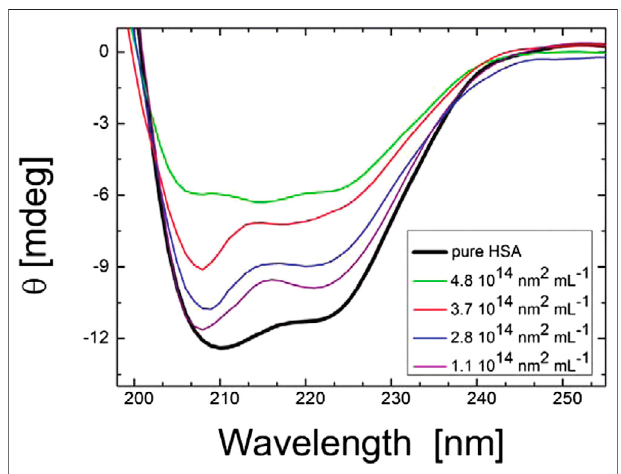
FIGURE 3 | CD spectra of HAS with citrate-stabilized silver nanoparticles (diameter of 36 nm with NP surface site concentrations ranging from 1.1 × 1014 to 4.8 × 1014 nm 2 mL − 1 and a protein concentration of 0.052 mg mL − 1 ). The fi gure and caption have been adapted with permission from (Gebauer et al., 2012), Copyright © 2012 American Chemical Society.